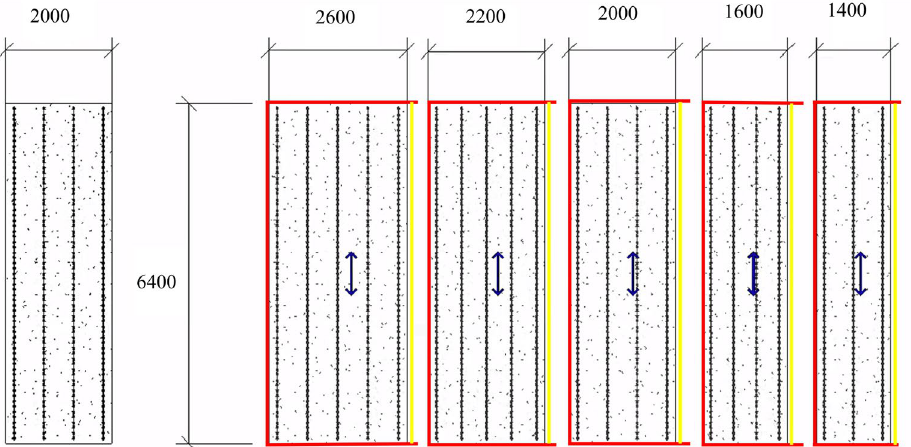
Figure 1. Standardised mode of prefabricated building